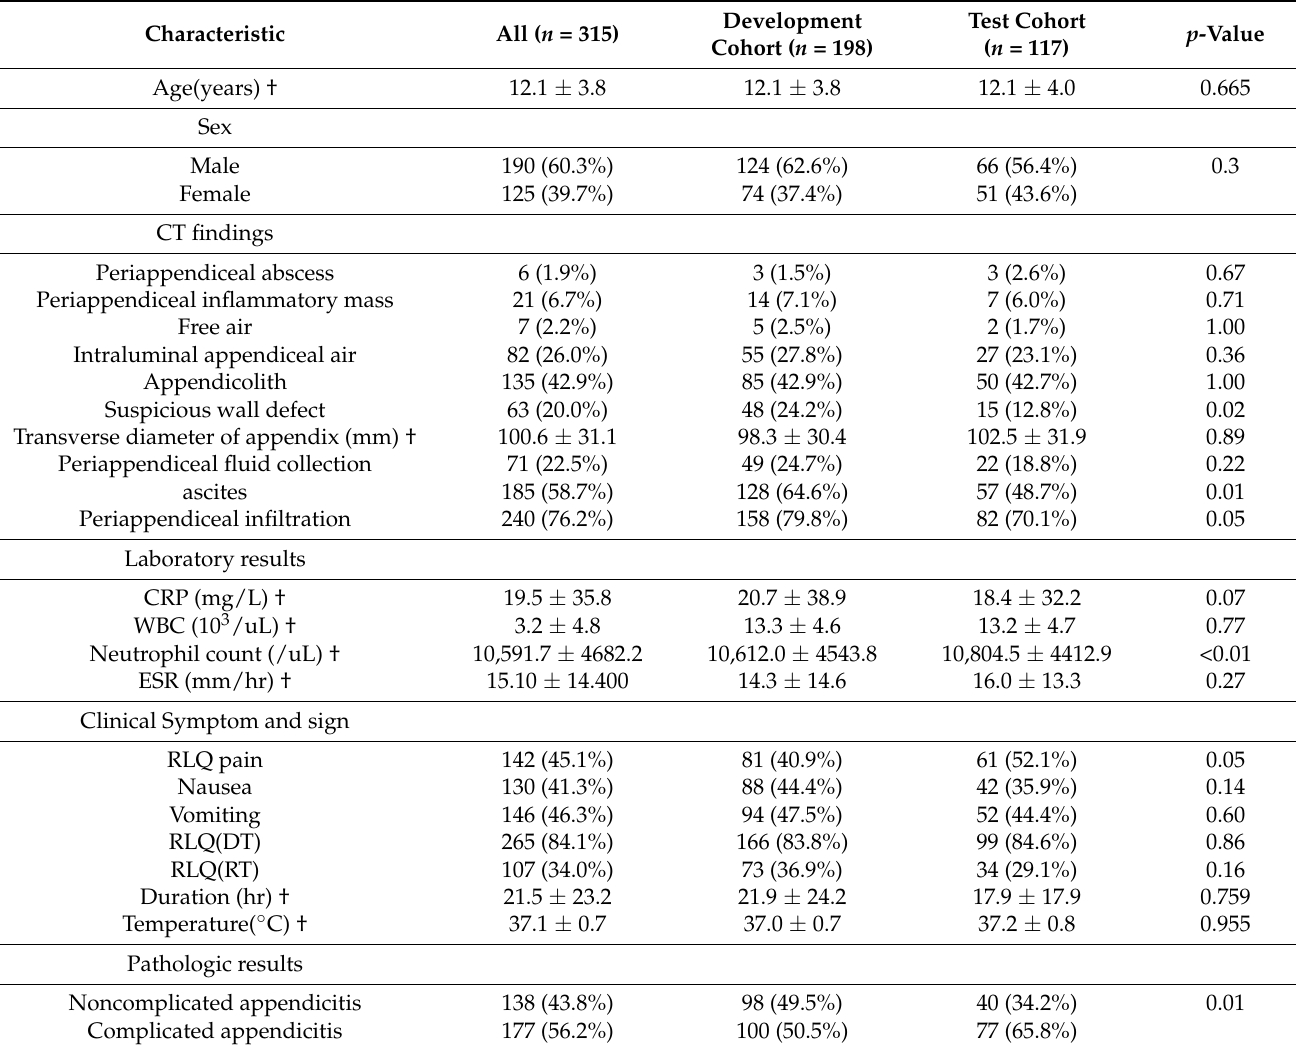
Table 1. Baseline characteristics of the study population.